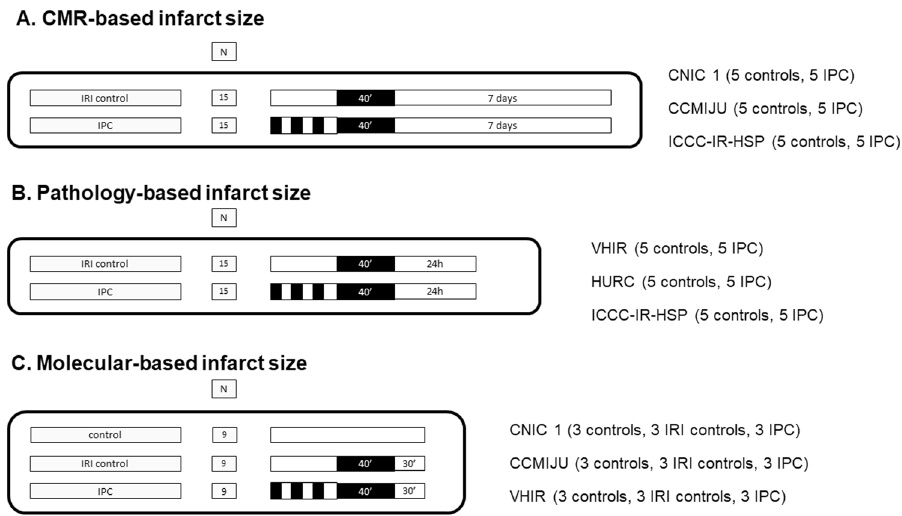
Figure 1. Study design involving at least 3 experimental groups per outcome and 5 core